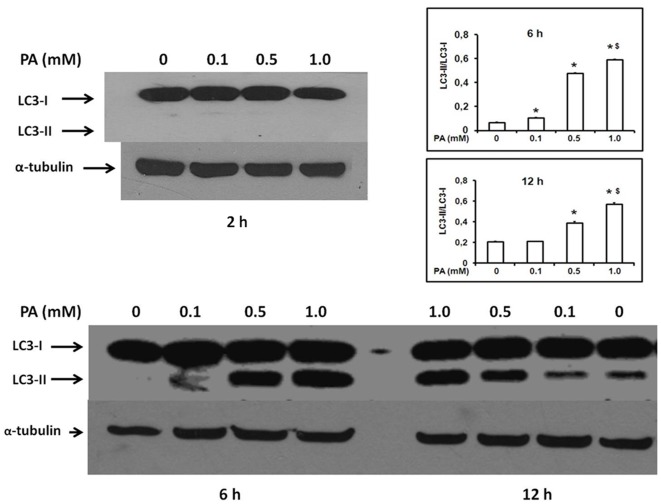
Immunoblotting of LC-3 protein in INS-1E cells after 2, 6 and 12 h treatment with various concentrations of palmitate (PA).α-tubulin was used as a control for loading. Methodological details are described in Materials and Methods. The figure is representative of gels obtained from three separate experiments. From these gels, band intensities were evaluated by densitometric analysis and expressed as the mean ± SEM of the ratio between LC3-II and LC3-I bands (lower graphs). * p<0.01 vs. untreated control; § p<0.01 vs. PA 0.5 mM.